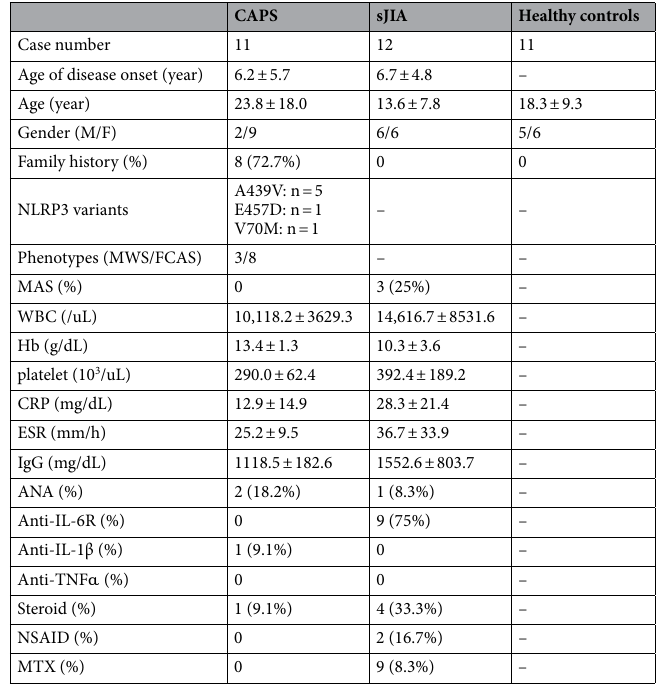
Table 1. Characteristics of the study cases. Abbreviations: CAPS-cryopyrin-associated periodic syndrome; sJIA-systemic juvenile idiopathic arthritis; NLRP3-NOD-like receptor family, pryin domain containing 3; MWS-Muckle–Wells syndrome; FCAS-familial cold autoinflammatory syndrome; MAS-macrophage activation syndrome; WBC-white blood cells; Hb-hemoglobulin; CRP-c-reactive protein; ESR-erythrocyte sedimentation rate; IgG-immunoglobulin G; ANA-antinuclear antibodies; IL-6R-interleukin 6 receptor; IL-1β-interleukin 1β; TNF ⍺ -tumor necrosis factor ⍺ ; NSAID-nonsteroidal anti-inflammatory drug; MTX- methotrexate.